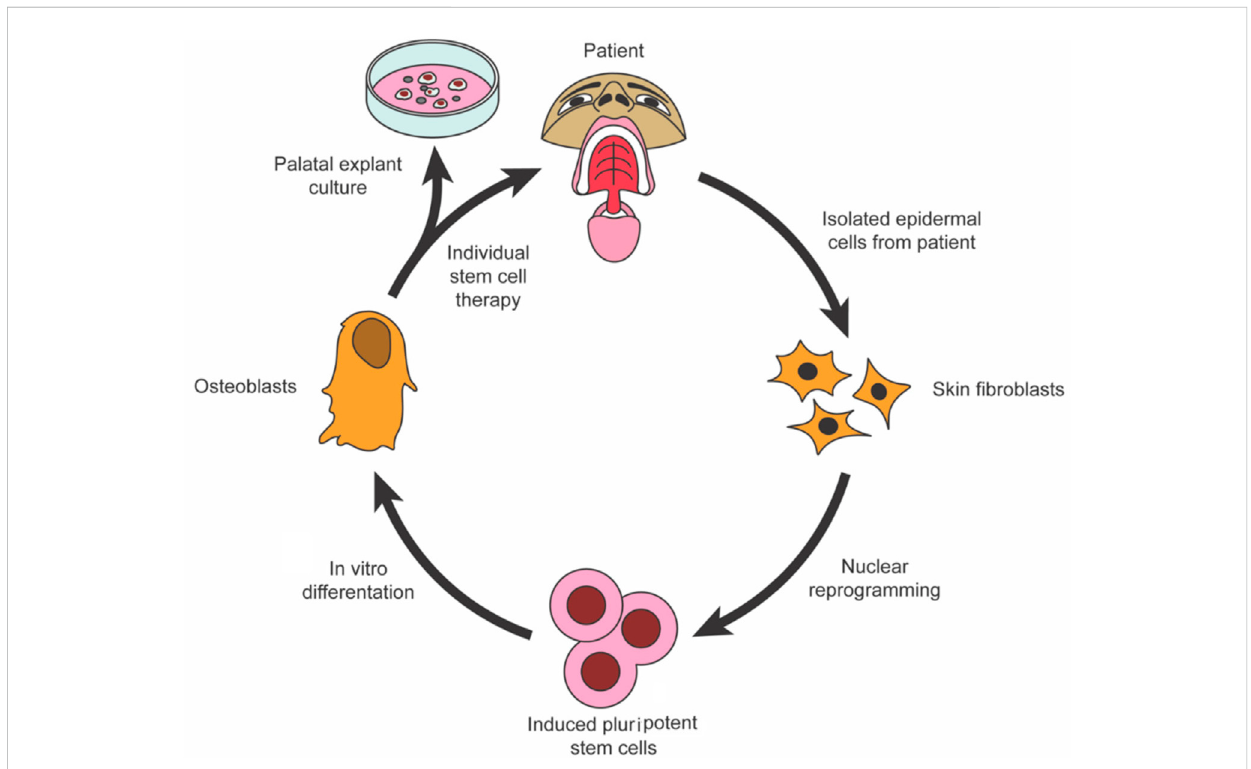
FIGURE 1 To restore palatal bone, iPSCs were isolated and programmed (Oliver et al.,